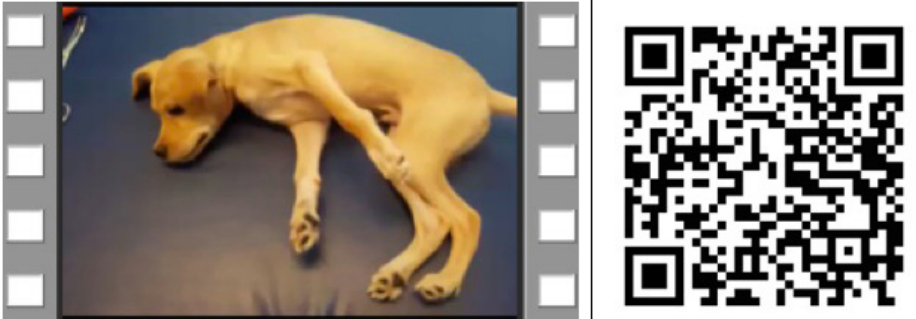
Figure 1. Clinical and therapeutic evolution of a 3-month-old male MBD dog, with congenital vertebral malformations. (Veterinary Hospital/UFRRJ– August/2019). Scan the QR Code to watch the video.